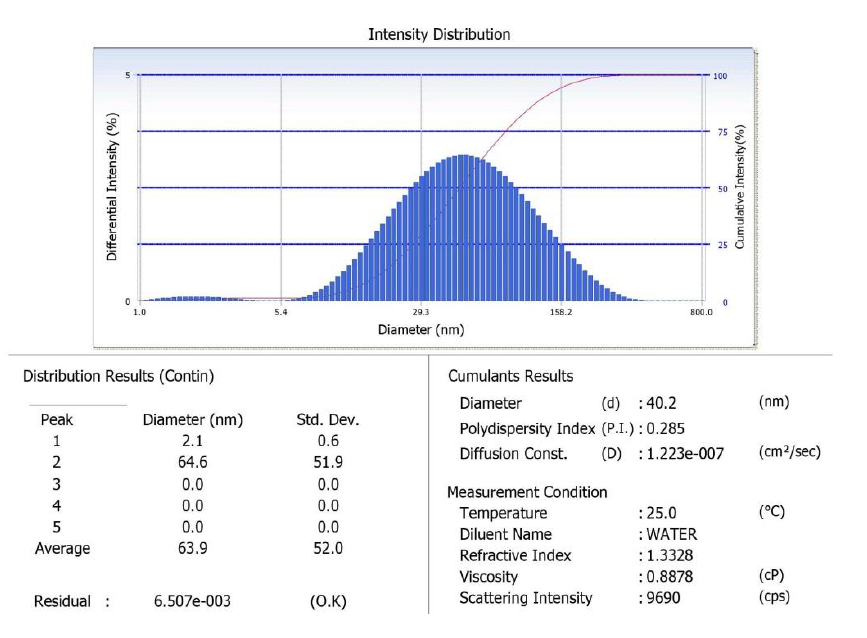
Figure 5. UV/Vis spectrum. The surface plasmon resonance peak of the Bs-AgNP solution ob- served at 450 nm confirmed the synthesis of small, polydisperse silver nanoparticles.